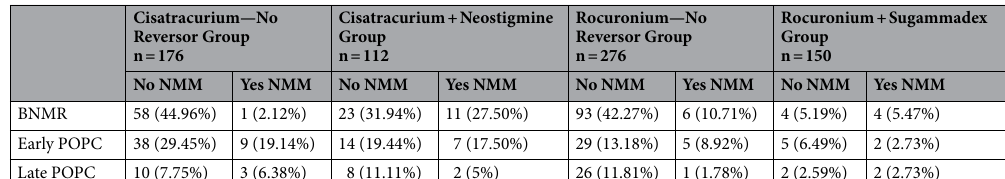
Table 2. Observed incidence of residual neuromuscular blockade, early and late postoperative pulmonary between groups if exists neuromuscular monitoring. Qualitative variables: quantity or absolute frequency (n), proportion or relative frequency (%—percent) for each group, along with independence tests (Chi2). *Significance defined as p-value < 0.05. RNMB Residual neuromuscular blockade, POPC postoperative pulmonary complications, NMM neuromuscular monitoring.